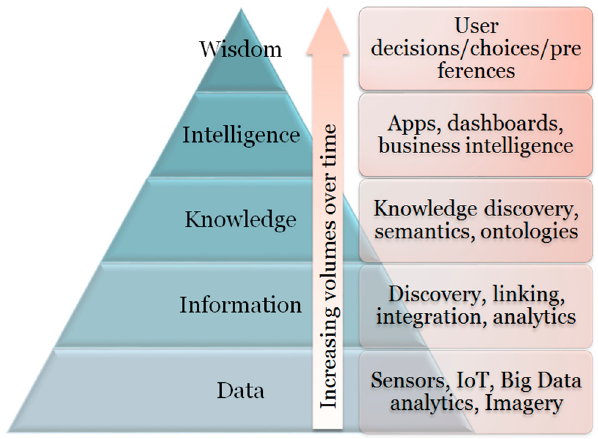
Figure 6. Trends and developments across the DIKIW pyramid.